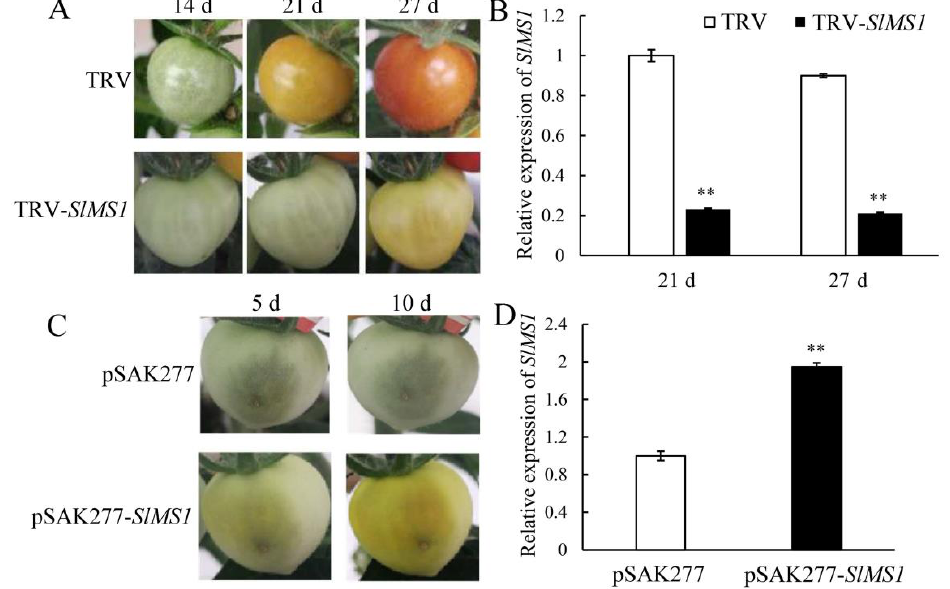
Figure 3. Transient silencing and transient overexpression of SlMS1 in the ripening process of